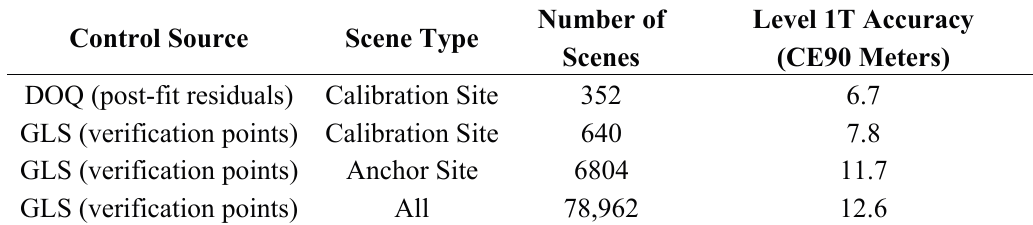
Table 4. Landsat 8 Level 1T product accuracy